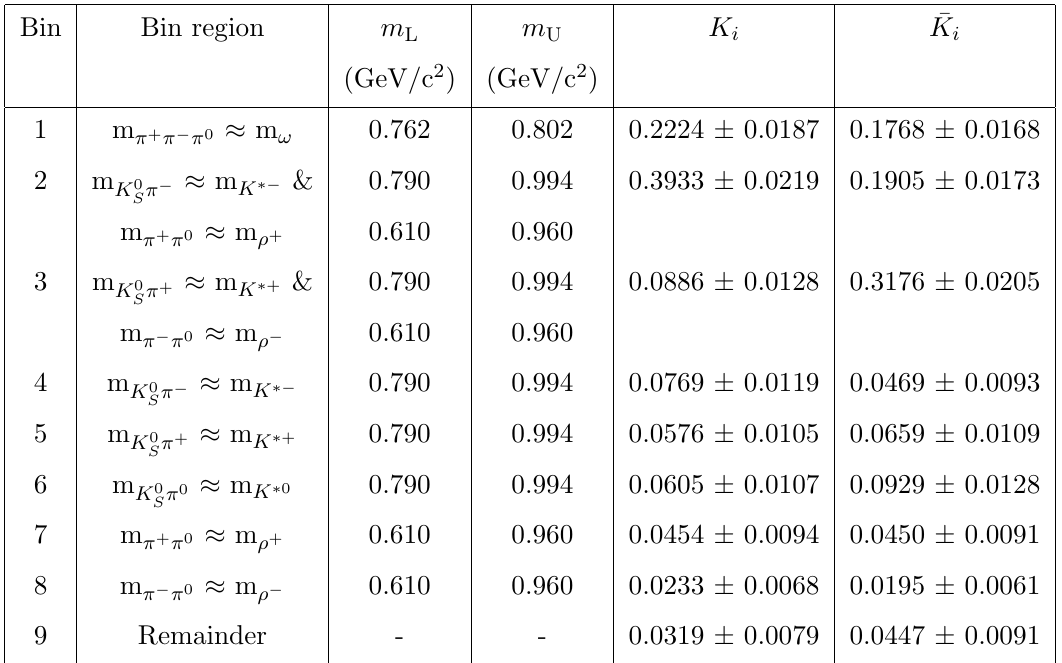
(cid:25) + (cid:25) (cid:0) (cid:25) 0 phase space along with the S